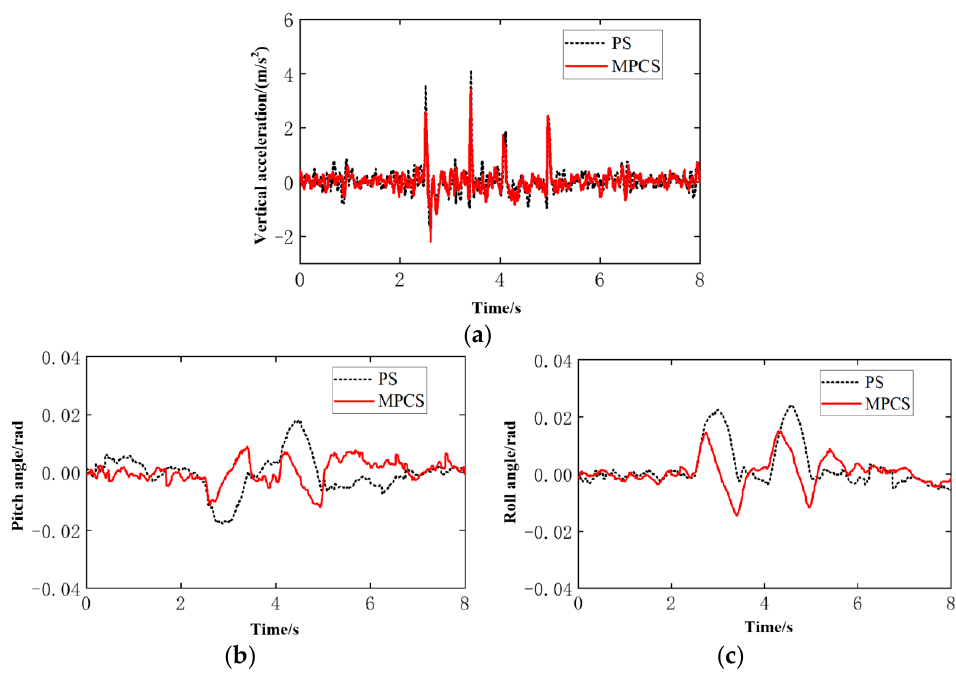
Figure 12. Experimental results of MPCS under the bump road disturbances: ( a ) Heaving acceleration of car body; ( b ) Pitching angle of car body; ( c ) Rolling angle of car body.